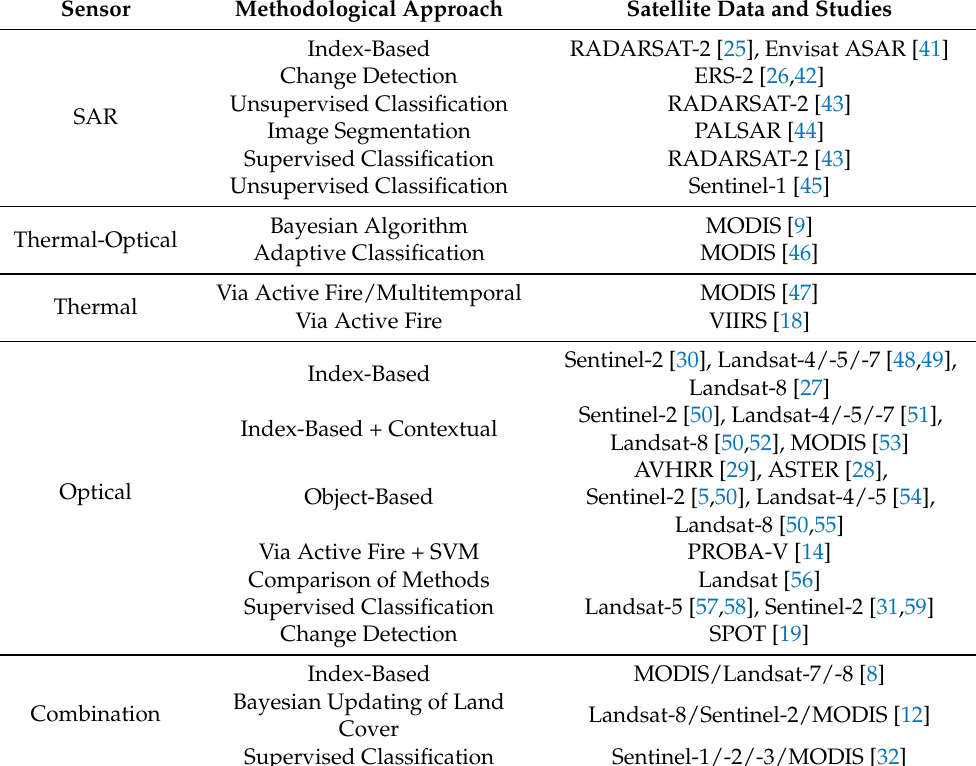
Table 2. Overview of the related work concerning burned area detection. The following abbrevia- tions are used: ERS—European Remote Sensing Satellite; MODIS—Moderate-resolution Imaging Spectroradiometer; VIIRS—Visible Infrared Imaging Radiometer Suite; AVHHR—Advanced Very High Resolution Radiometer; ASTER—Advanced Spaceborne Thermal Emission and Reflection Ra- diometer; Proba-V—Project for On-Board Autonomy-Vegetation; SPOT—Satellite Pour l’Observation de la